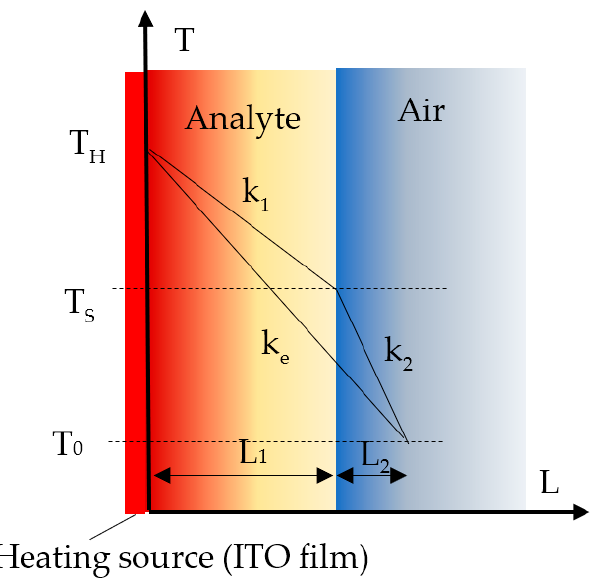
gradient is assumed as k e .